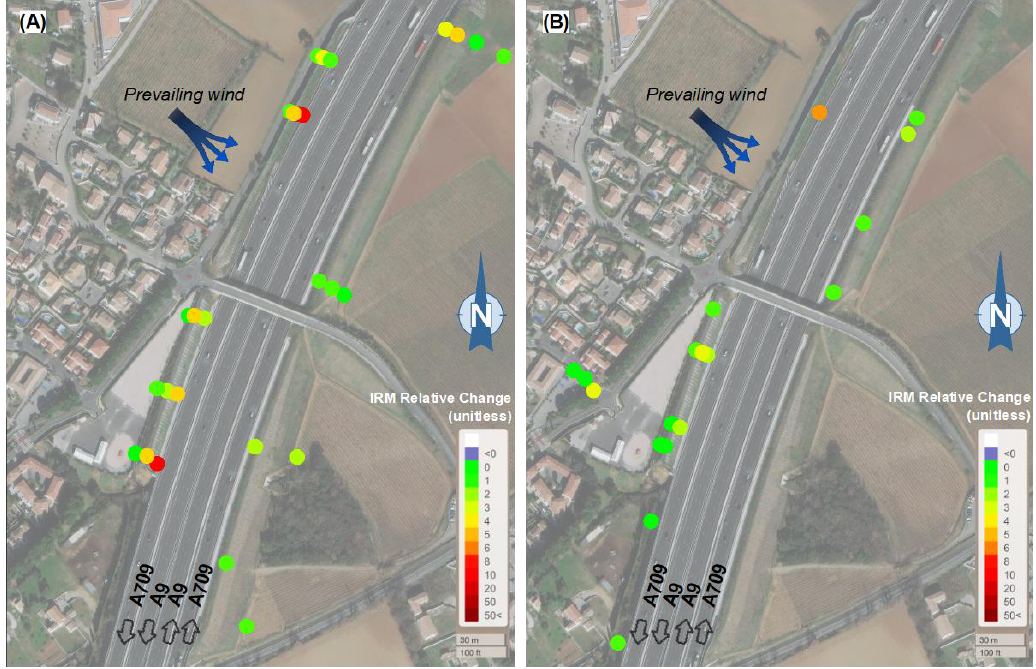
Figure 5. Maps of traffic-derived particulate matter (PM) measured by Isothermal Remanent Magnetization (IRM) relative change (RC) on: ( A ) artificial filters and ( B ) Cercis Siliquastrum leave samples. Image from Google Earth V7.3.3.7721 digital Globe 10 July 2018.